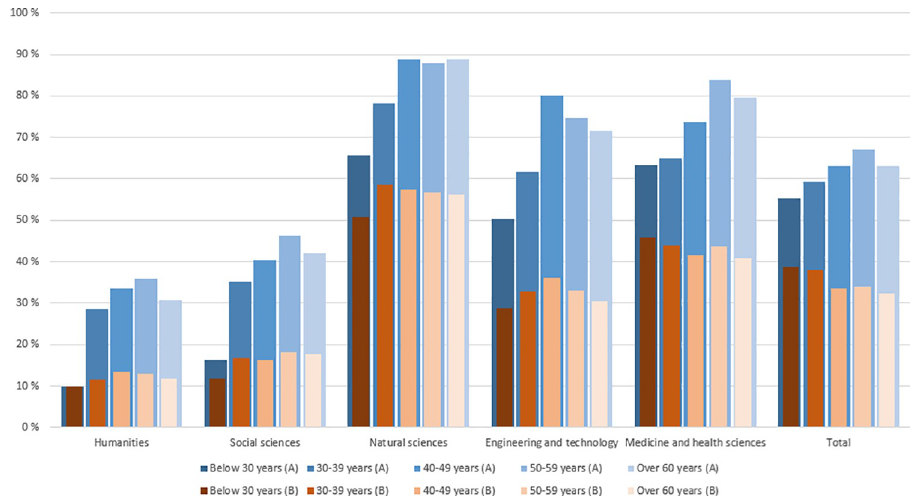
Fig 2. Proportion of researchers (indicator A) involved in international collaboration and average proportion of publications with international collaboration per researchers (indicator B) by major fields and age groups (N = 5,554).